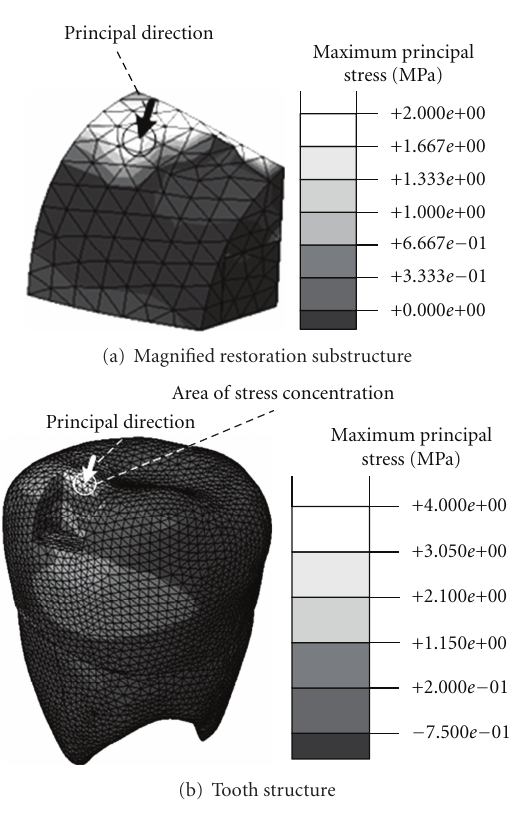
Figure 12: The predicted maximum principal stress of the restora- tion and tooth phases under the simulated mastication